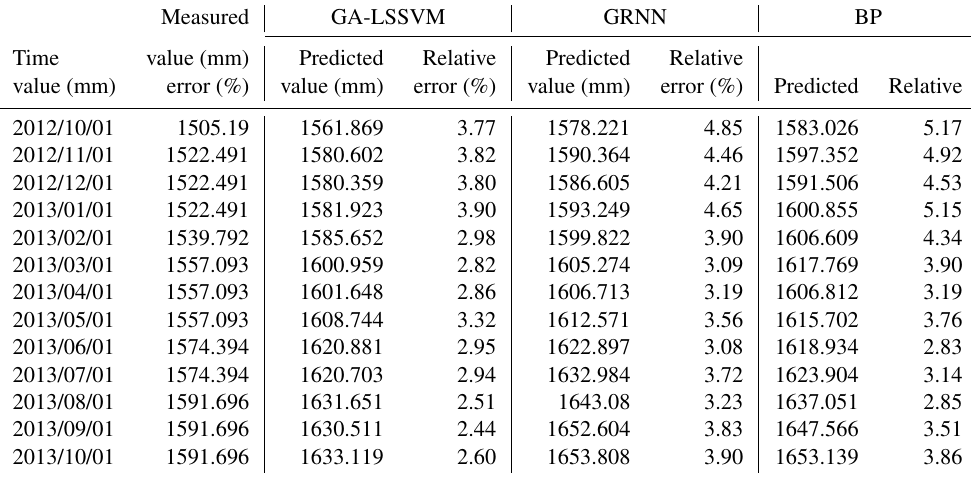
2013/08/01 1591.696 2013/09/01 2013/10/01